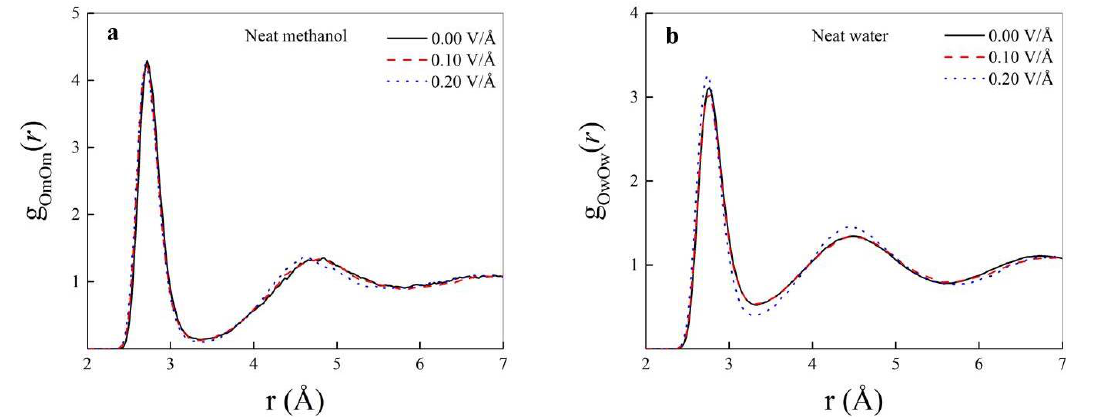
Figure 2. Oxygen-oxygen radial distribution functions (RDFs) in bulk neat methanol ( a ) and in bulk neat water ( b ) in the zero-field regime (solid black curves) and for different field strengths. Dashed red curves: 0.10 V/Å; dotted blue curves: 0.20